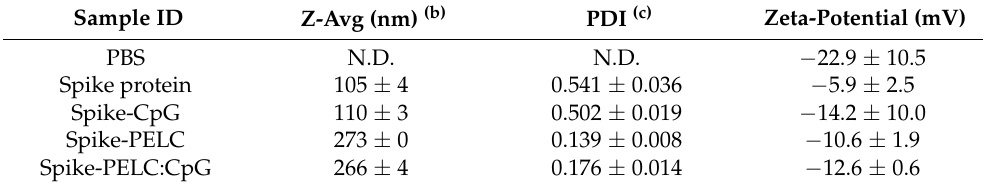
Table 1. Particle analysis of the designed spike-PELC:CpG formulations by light-scattering technology (a)